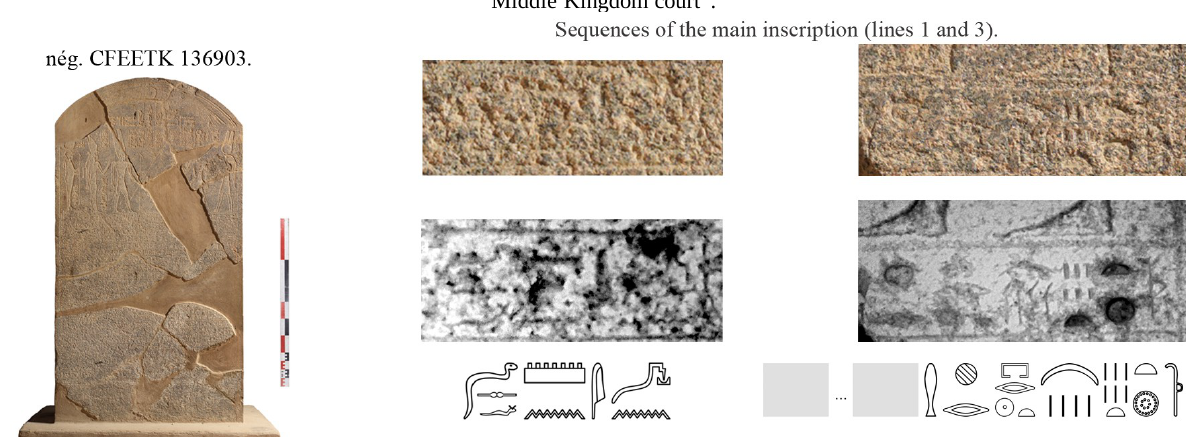
7: Depth maps application on temple furniture: the case of the support of Sekhemre-Seouadjtaouy (XIII th dynasty) in the “Middle Kingdom court”.